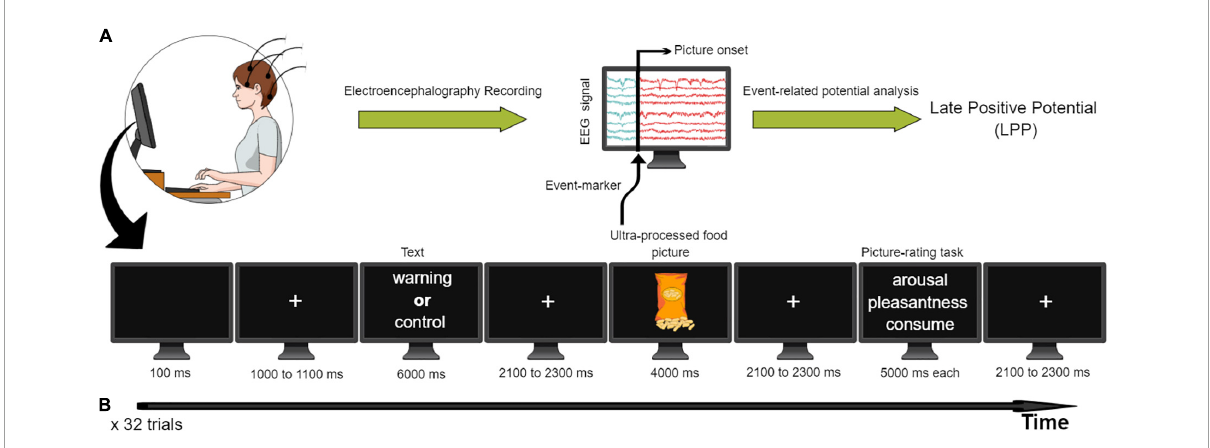
FIGURE1 (A) The event-related potential waveform late positive potential (LPP) was extracted from the raw electroencephalographic signal. The event of interest (UPF picture) was presented to the participant on a computer screen while the electroencephalographic (EEG) signal was being recorded. Event-markers (i.e., triggers) in the EEG signal time-locked to the UPF picture onset defined the segments from the EEG signal to be analyzed. After conducting 32 trials containing different UPF pictures, the EEG signal was averaged across the segments, revealing the event-related potential waveform–late positive potential (LPP). (B) Experimental design showing the sequence of events during the experiment. Participants viewed pictures depicting UPF preceded by a control text (the first block comprising 32 trials, control condition) or a warning text (the second block comprising the 32 remaining trials, warning condition). After viewing the UPF picture, participants rated it in two basic dimensions of emotion: arousal and pleasantness. They also rated their intention to consume the foods depicted in the pictures. UPF, ultra-processed food; EEG, electroencephalographic; LPP, late positive